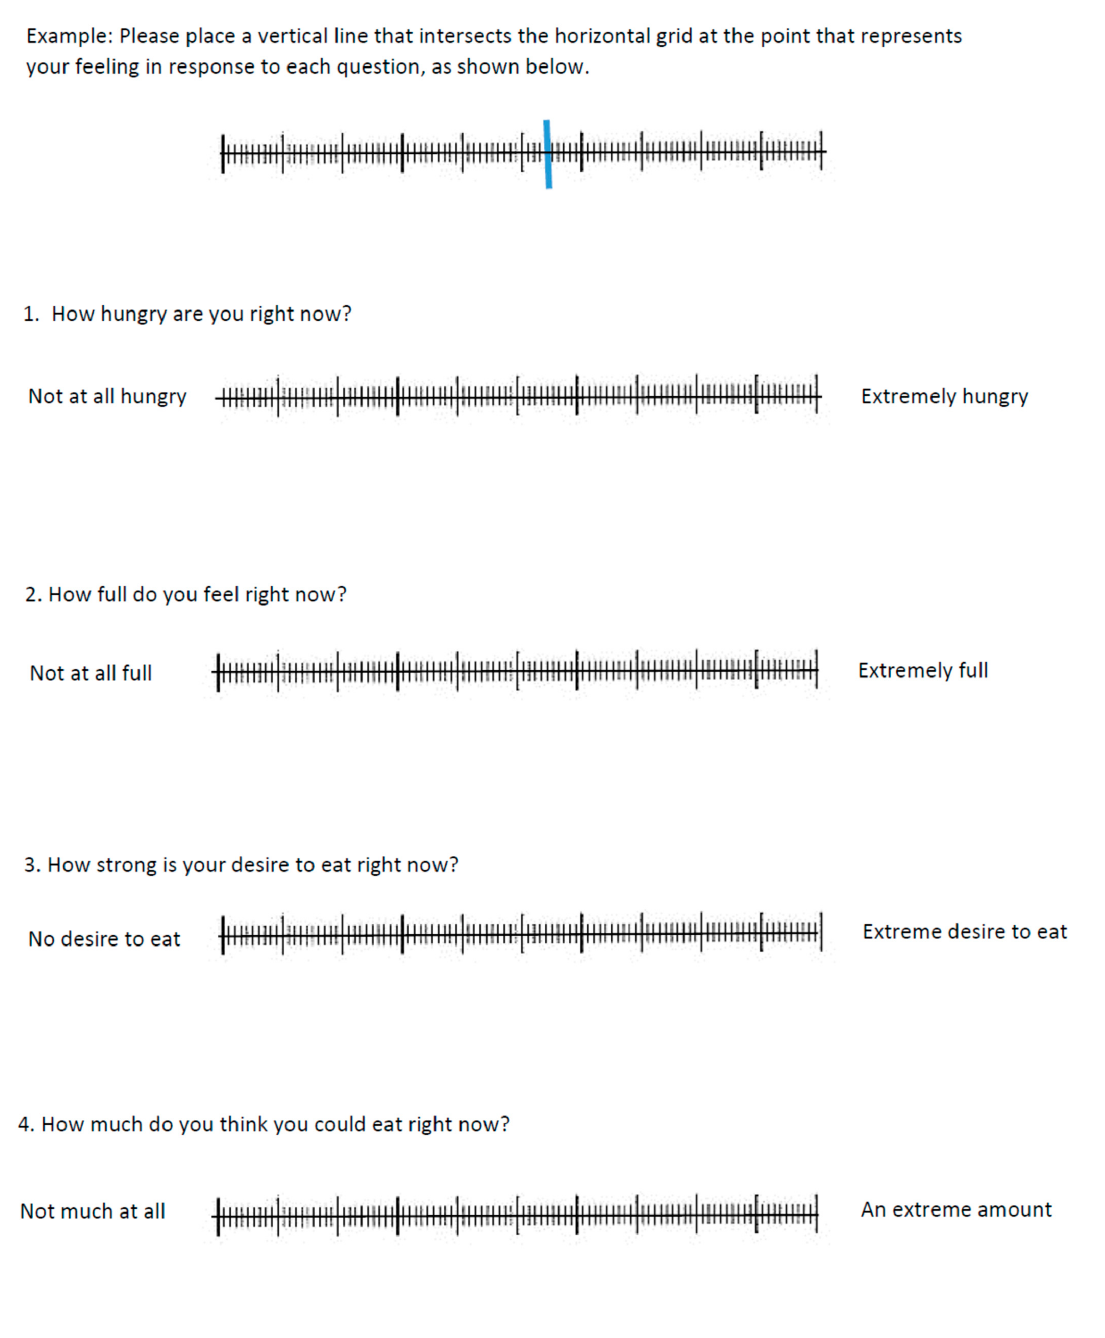
Nutrients 2023 , 15 , B-4: Visual Analog Appetite Rating Scales (VAS)